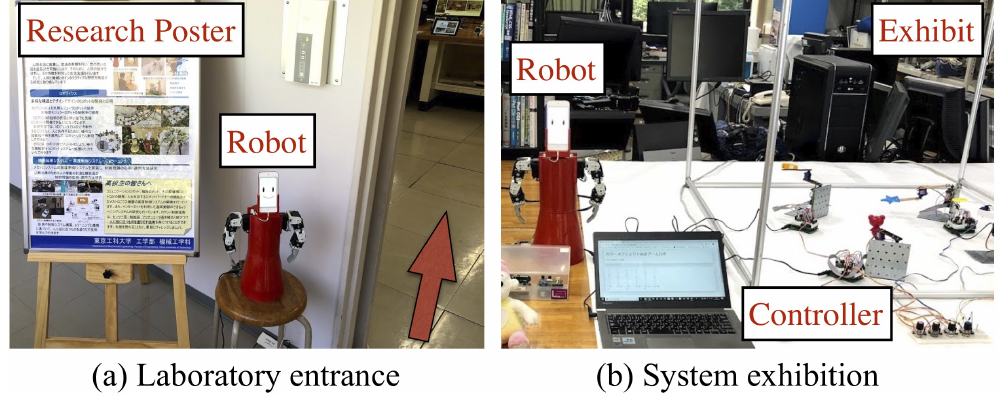
Figure 16. Application example of robot